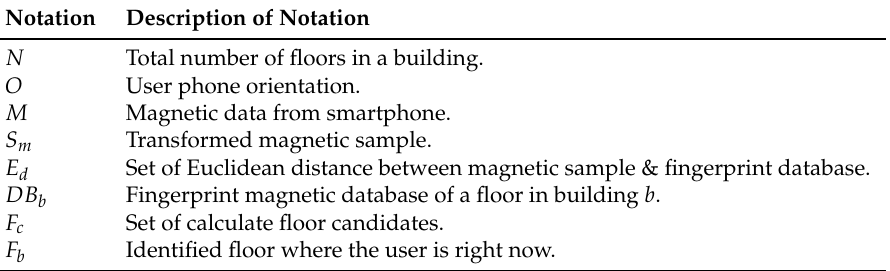
Table 1. Summary of the notations used in Algorithm 1.